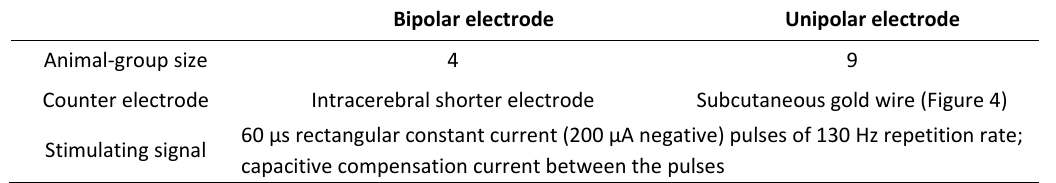
Table 1: Experimental i n vivo conditions